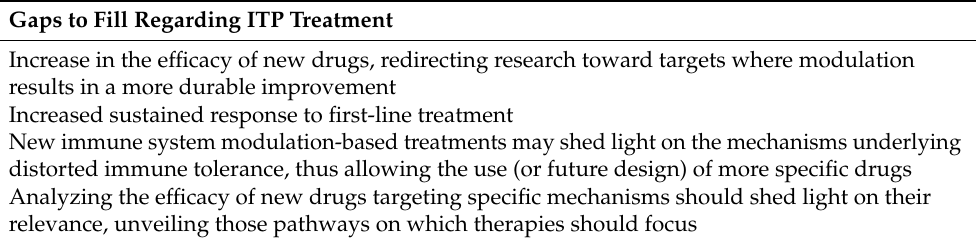
Table 4. New therapies that may contribute to filling unmet needs in ITP treatment.